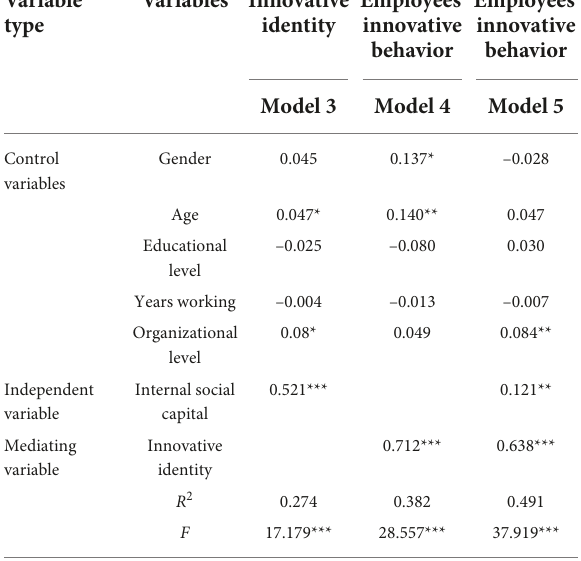
TABLE 7 Mediating effect analysis results.